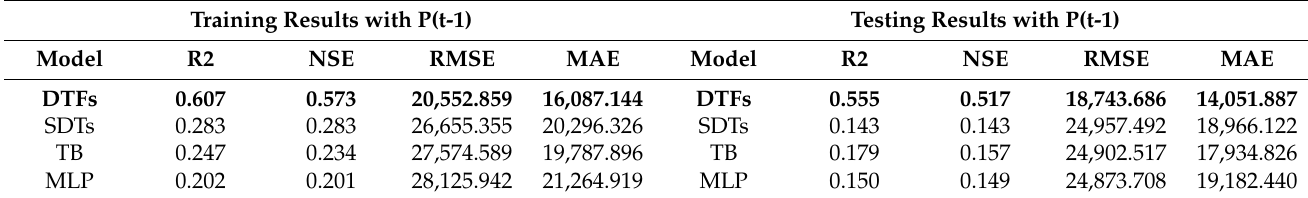
Table 4. Training and testing results with Q(t-1) of different data mining techniques.